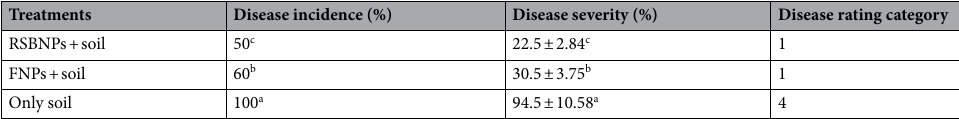
Table 4. Effect of rice straw biochar nanoparticles (RSBNPs) and fly ash nanoparticles (FNPs) on the incidence and severity of Xanthomonas campestris pv . vesicatoria in chili